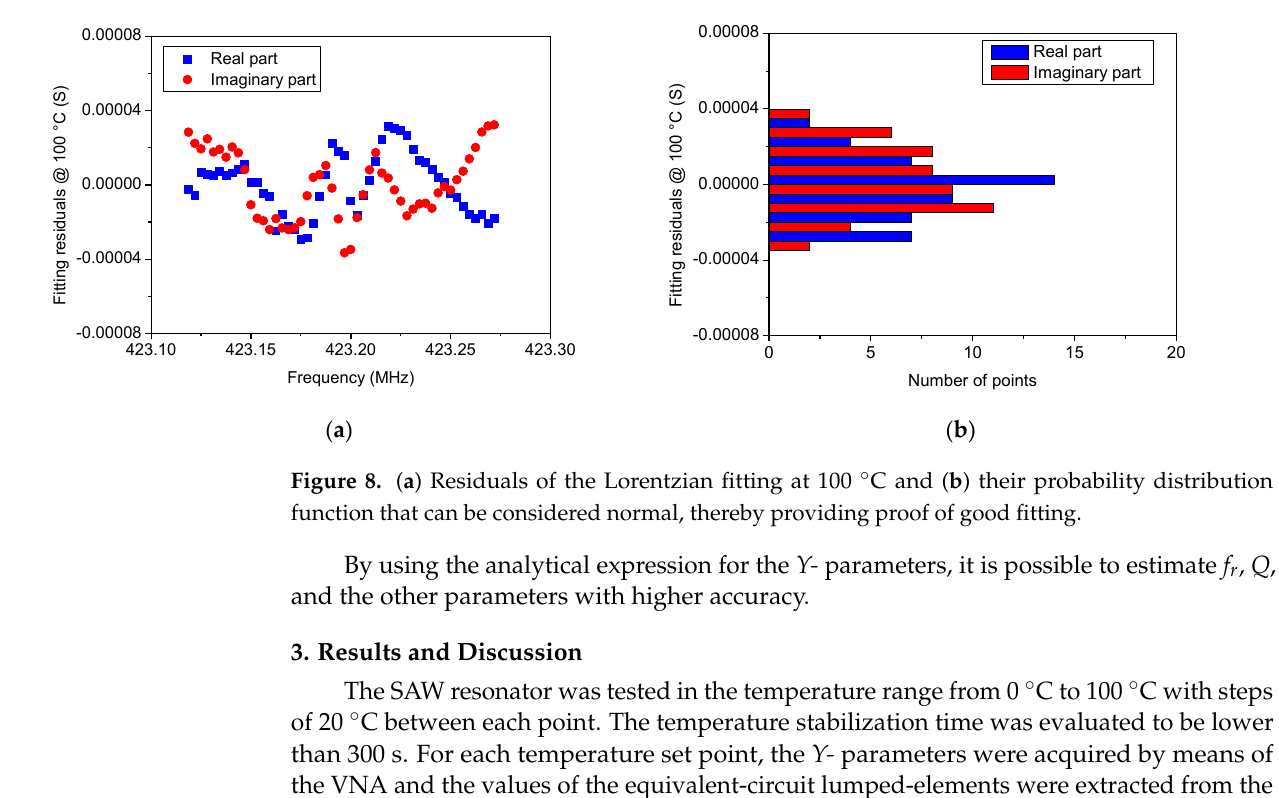
Figure 7. Comparison between measurements and Lorentzian fitting on the ( a ) Re( Y 22 ) and ( b ) Im( Y 22 ) for the tested SAW resonator at 100 °C.